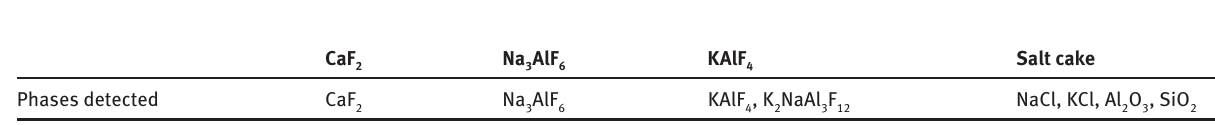
Table 2: Summary of phases detected by XRD in slag